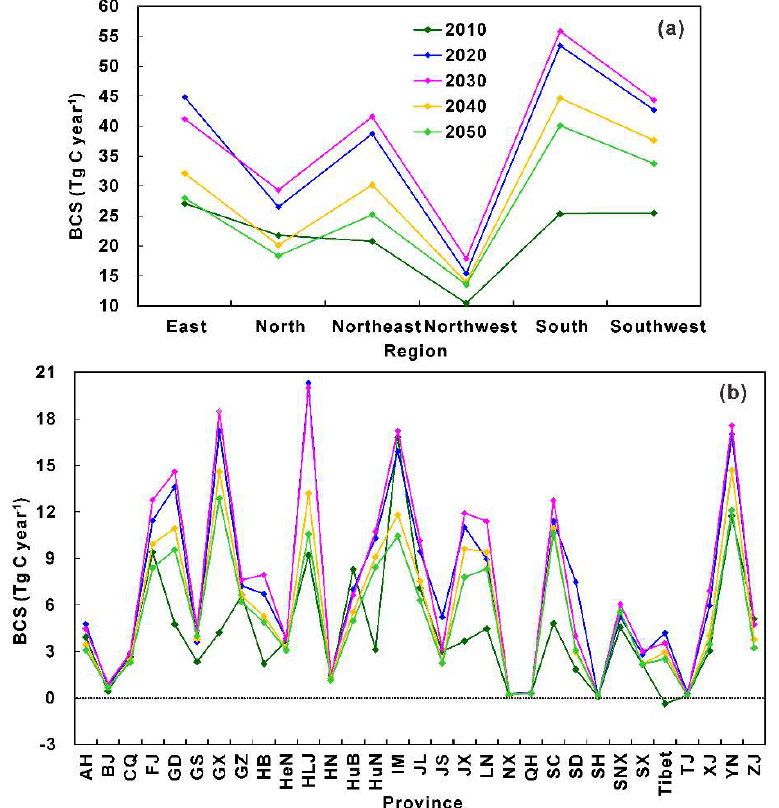
Figure 4. Trends of forest BCS in different ( a ) regions and ( b ) provinces of China during the period from 2010 to 2050. Data in 2010 were estimated from the national forest inventory data of 2009−2013 [14]. Negative values indicate a carbon source, and vice versa. Province letter designations are stated in the Figure 1 caption.